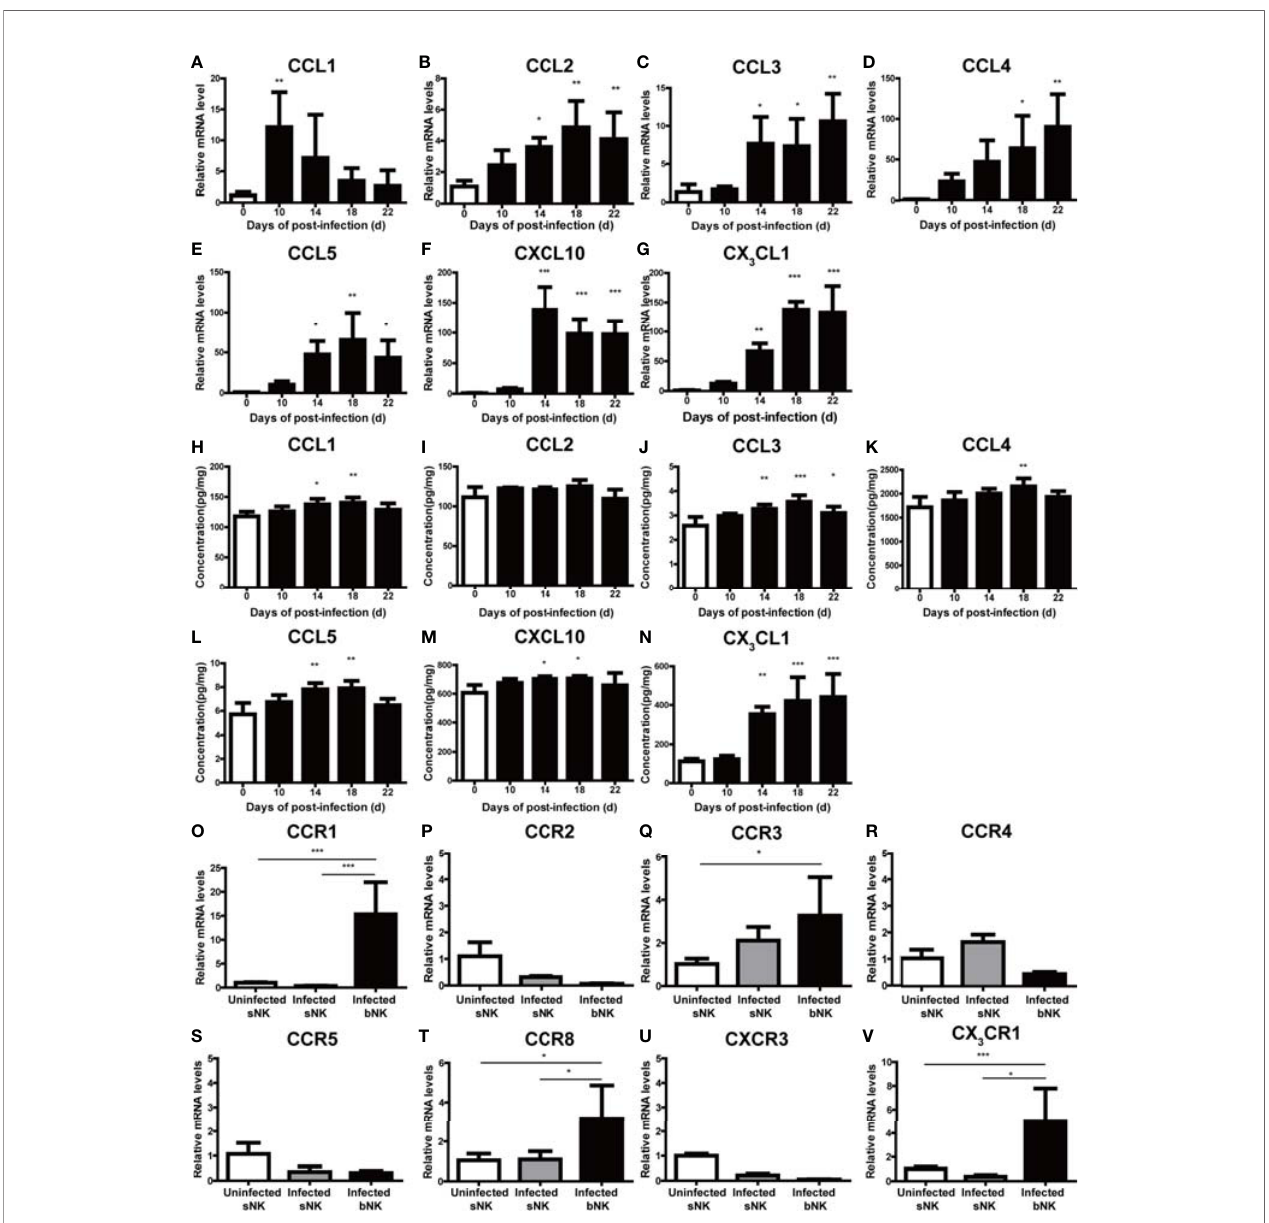
FIGURE 8 | The expression of CX 3 CL1 in the brain tissue and CX 3 CR1 on the CNS-in fi ltrated NK cells were elevated after A. cantonensis infection. The gene (A – G) and protein levels (H – N) of various chemokines (CCL1, CCL2, CCL3, CCL4, CCL5, CXCL10 and CX 3 CL1) in brain tissue were measured by qRT-PCR and ELISA. (O – V) The gene expression levels of chemokine receptors (CCR1, CCR2, CCR3, CCR4, CCR5, CCR8, CXCR3 and CX 3 CR1) on NK cells were detected by qRT- PCR. Multiple comparisons were performed by ANOVA. * P < 0.05; ** P < 0.01; *** P < 0.001. sNK, NK cells in spleen; bNK, NK cells in